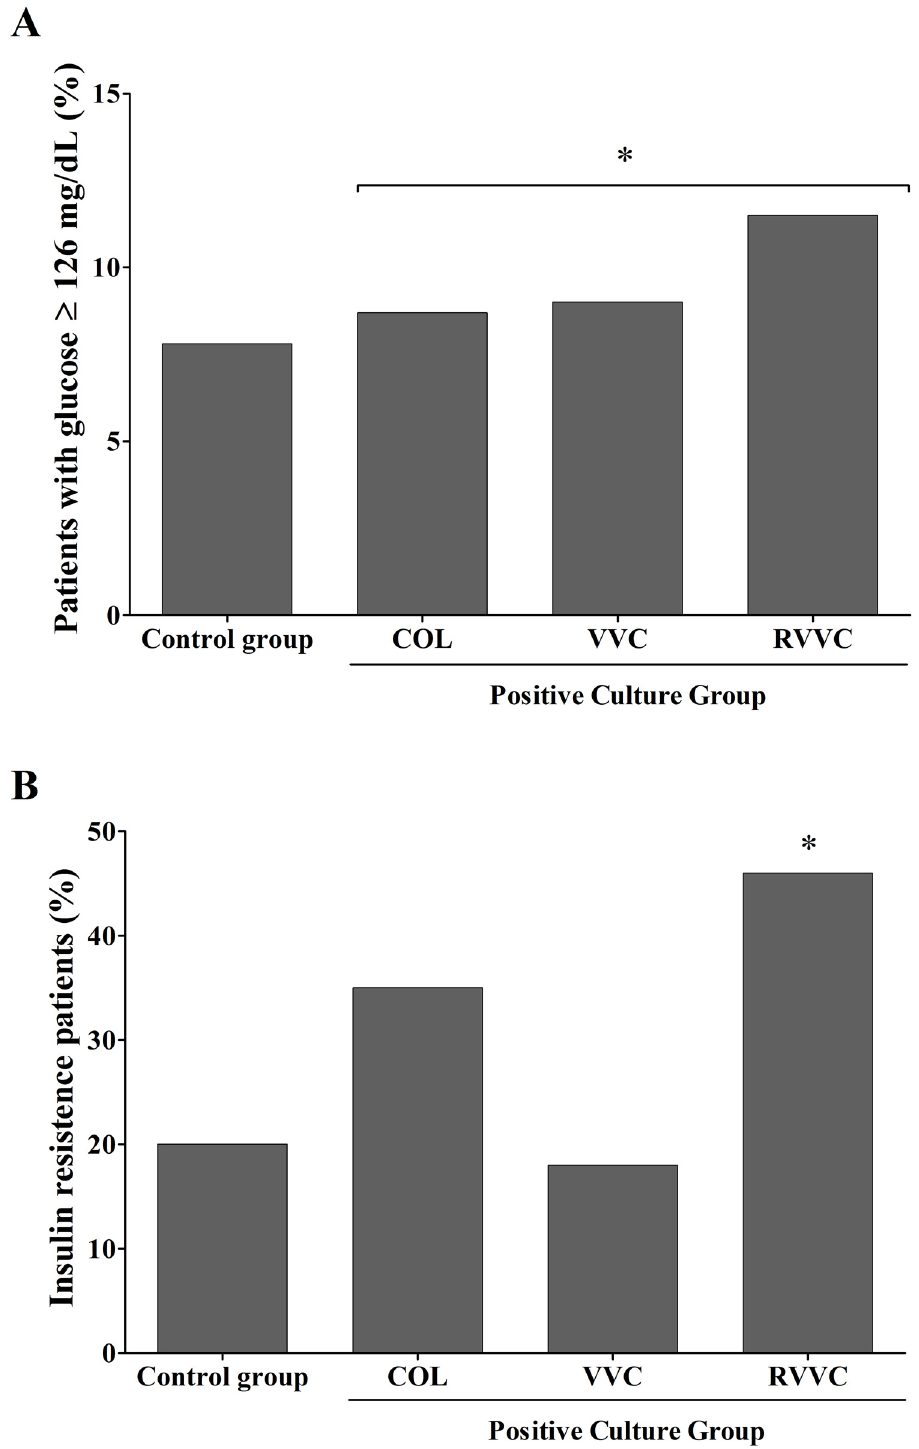
Fig 2. Abnormal glycemia and insulin resistance in 277 women studied. A. Percentage of women with abnormal glycemia ( (cid:1) 126 mg/dL) in control group compared to positive vaginal yeast culture group (colonized-COL, vulvovaginal candidiasis-VVC and recurrent VVC-RVVC). Positive culture group had more women with abnormal glycemia than control group ( * p = 0.0002). B. Percentage of women with insulin resistance (HOMA Index (cid:1) reference value according to body mass index-BMI) in positive vaginal